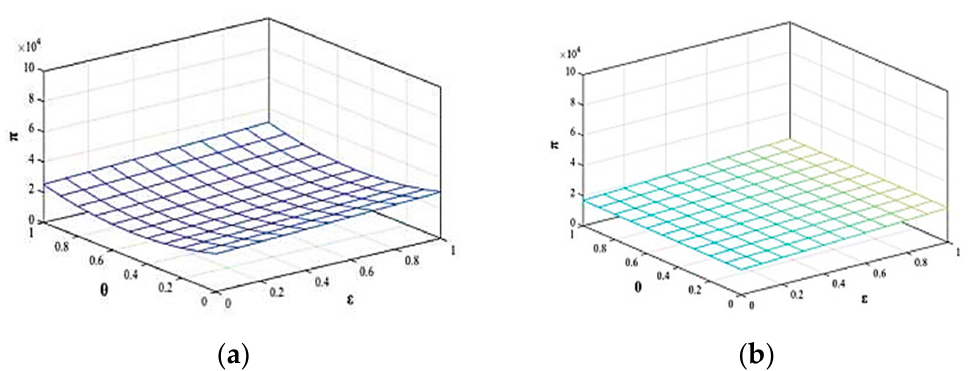
Figure 2. Total profit under ( a ) differential pricing and ( b ) uniform pricing.